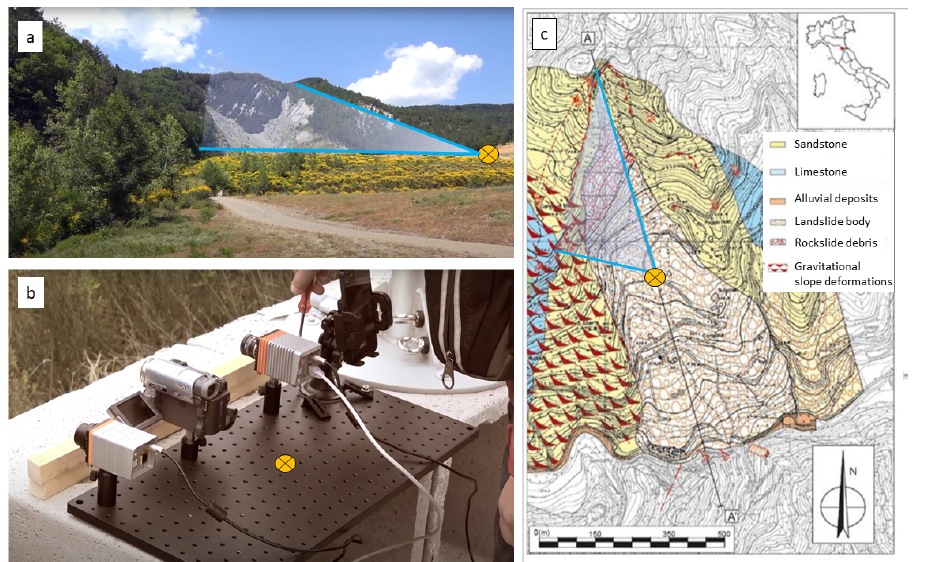
Figure 1. ( a ) Photo of the landslide with its surrounding environment. ( b ) Optical system used for multi-wavelength imaging. From left to right: Thermal infrared (TIR) camera, low- resolution visible camera for image selection and alignment among sensors, short wavelength IR (SWIR) camera, and smartphone for high-resolution visible imaging. ( c ) Geological map of the Poggio Baldi landslide area; [26] modified from [27]. In each panel, a yellow black-crossed dot indicates the position of the optical system including the TIR camera.